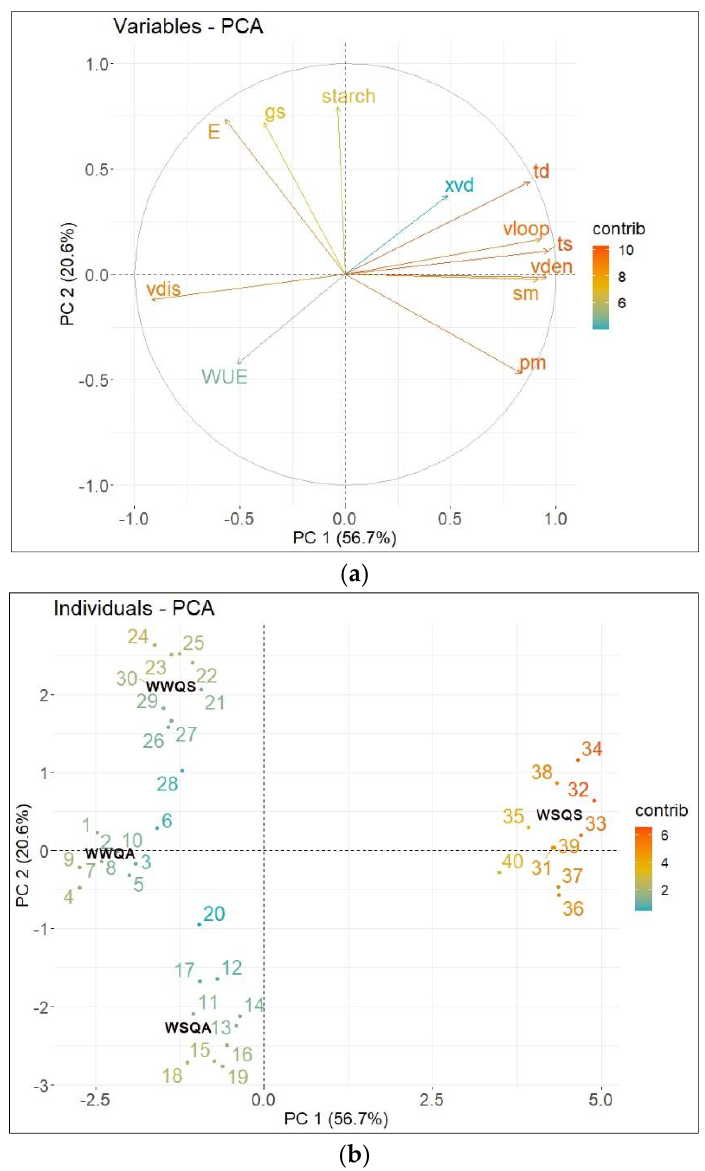
Figure 8. ( a ) Loading plot of the relationship between anatomical and physiological traits and ( b ) loading plot of individuals of well-watered (WW) and water-stressed seedlings of Quercus acutissima and Q. serrata . Abbreviations: WWQA—well-watered seedlings of Q. acutissima ( samples 1–10)